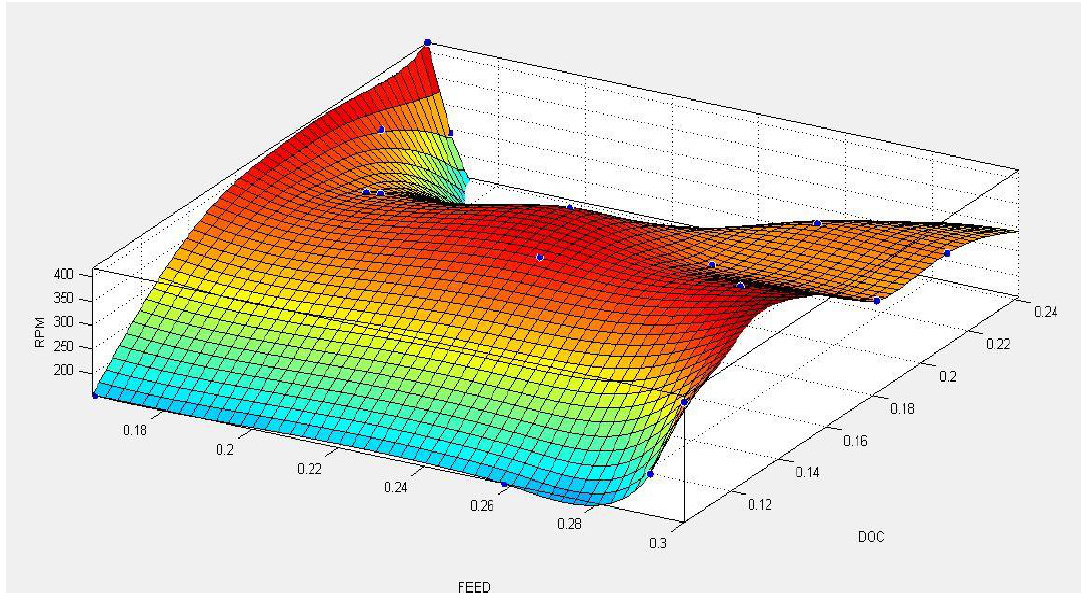
Figure 14. Optimal design variables in search space.